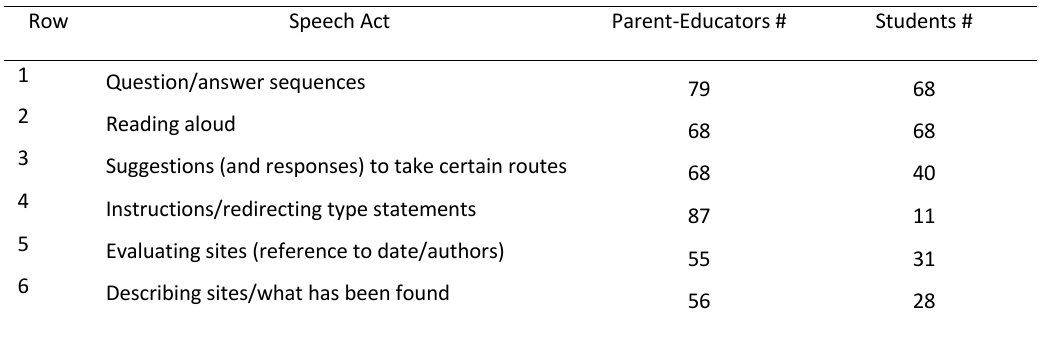
Table 1. Tally of Speech Acts during ‘collaborative’